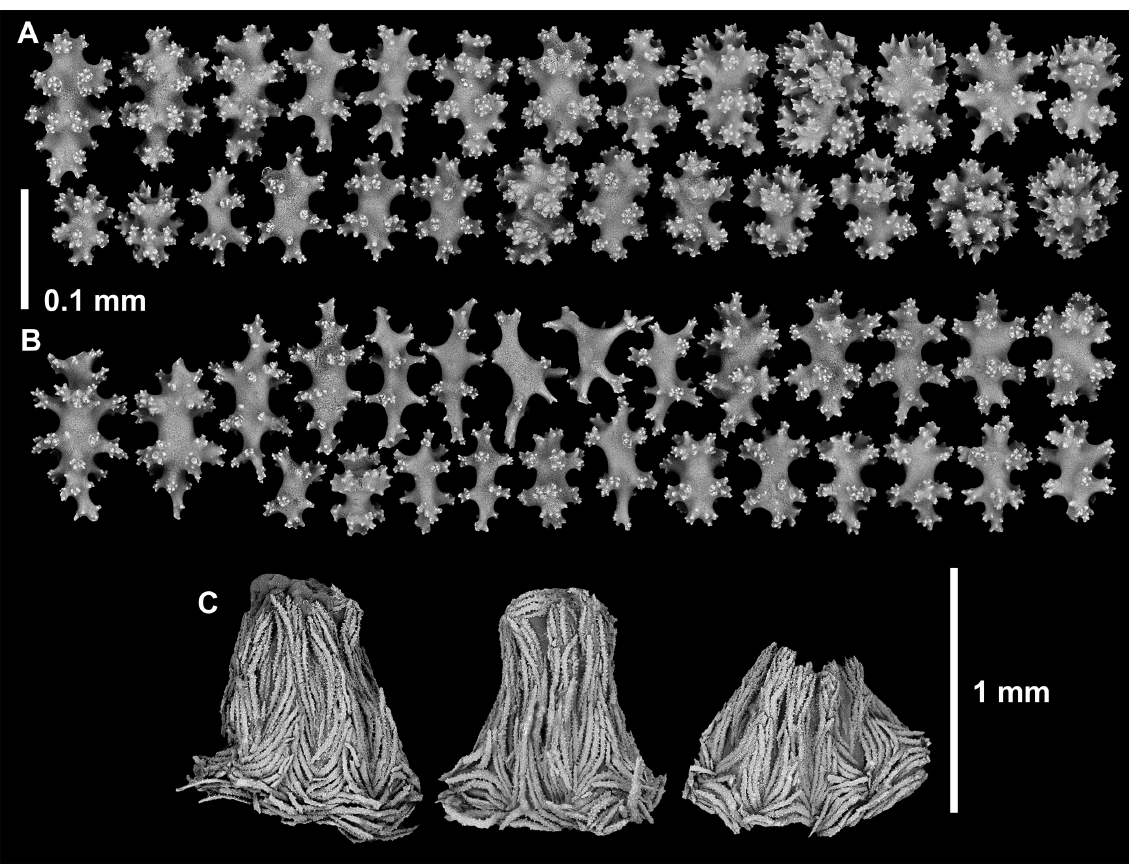
Fig. 6. Kotatea amicispongia gen. et sp. nov., holotype (NIWA 156312), SEMs of sclerites. A . Base surface. B . Base interior. C . Polyps (in